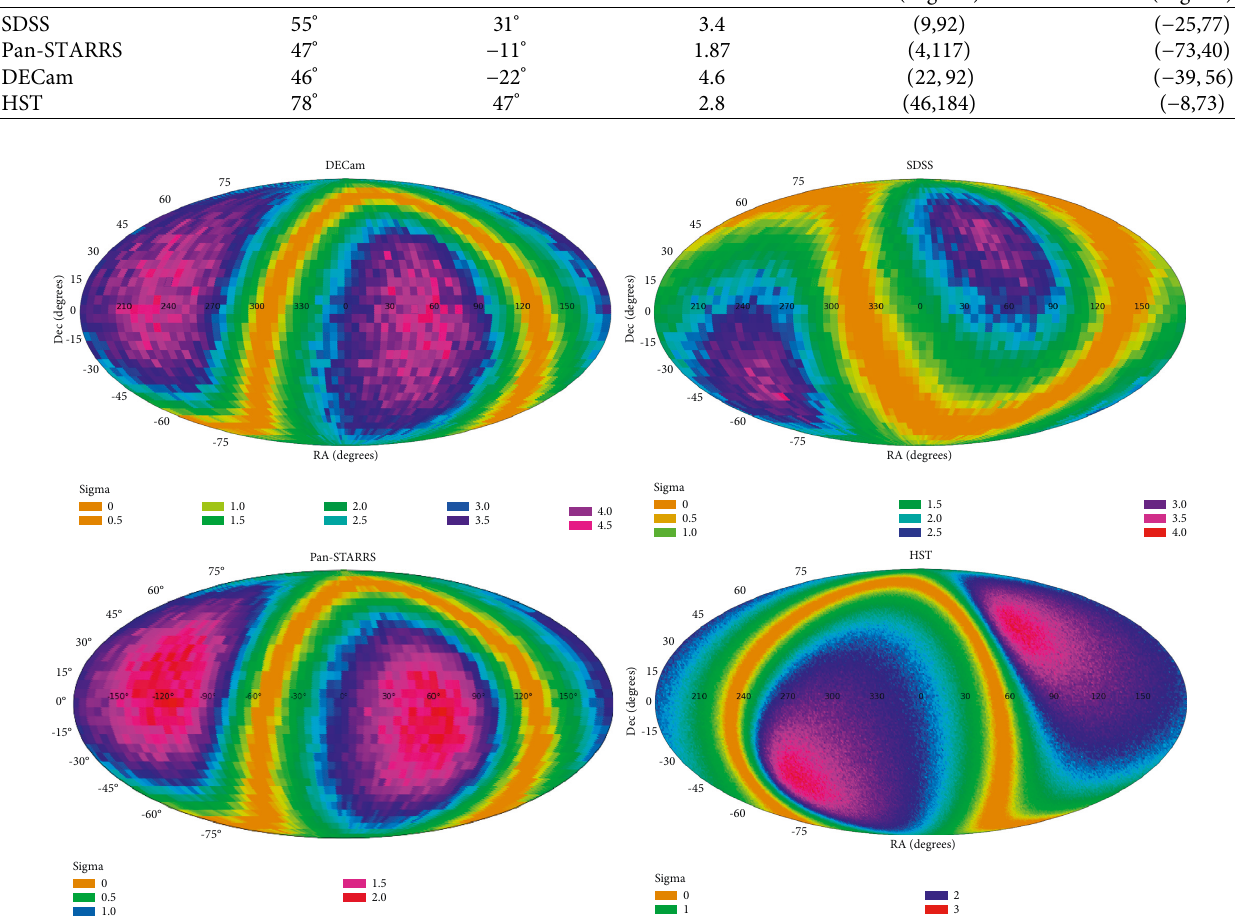
Figure 6: The probability of a dipole axis in galaxy spin directions from different ( α , δ ) combination in SDSS, Pan-STARRS, DECam, and